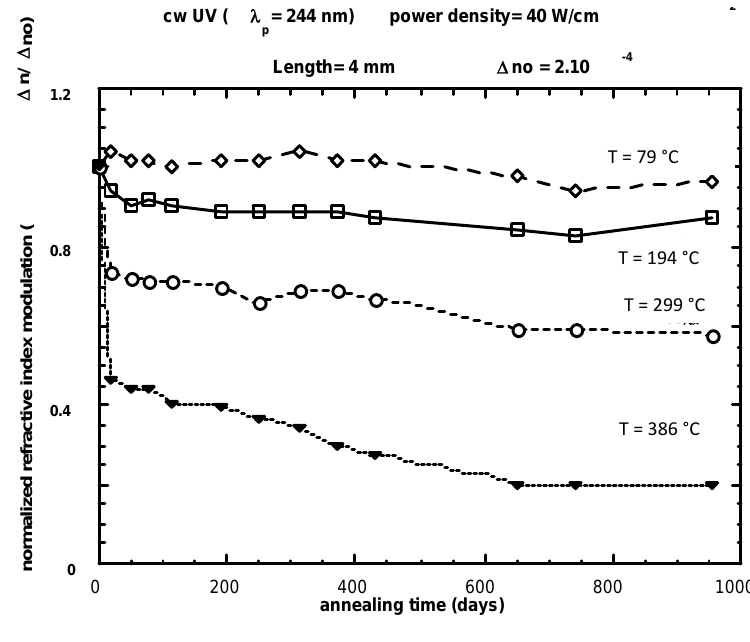
Figure 30. Isotherms from Razafimahatratra, reprinted with permission from [37]. Copyright 2000 University Lille 1.